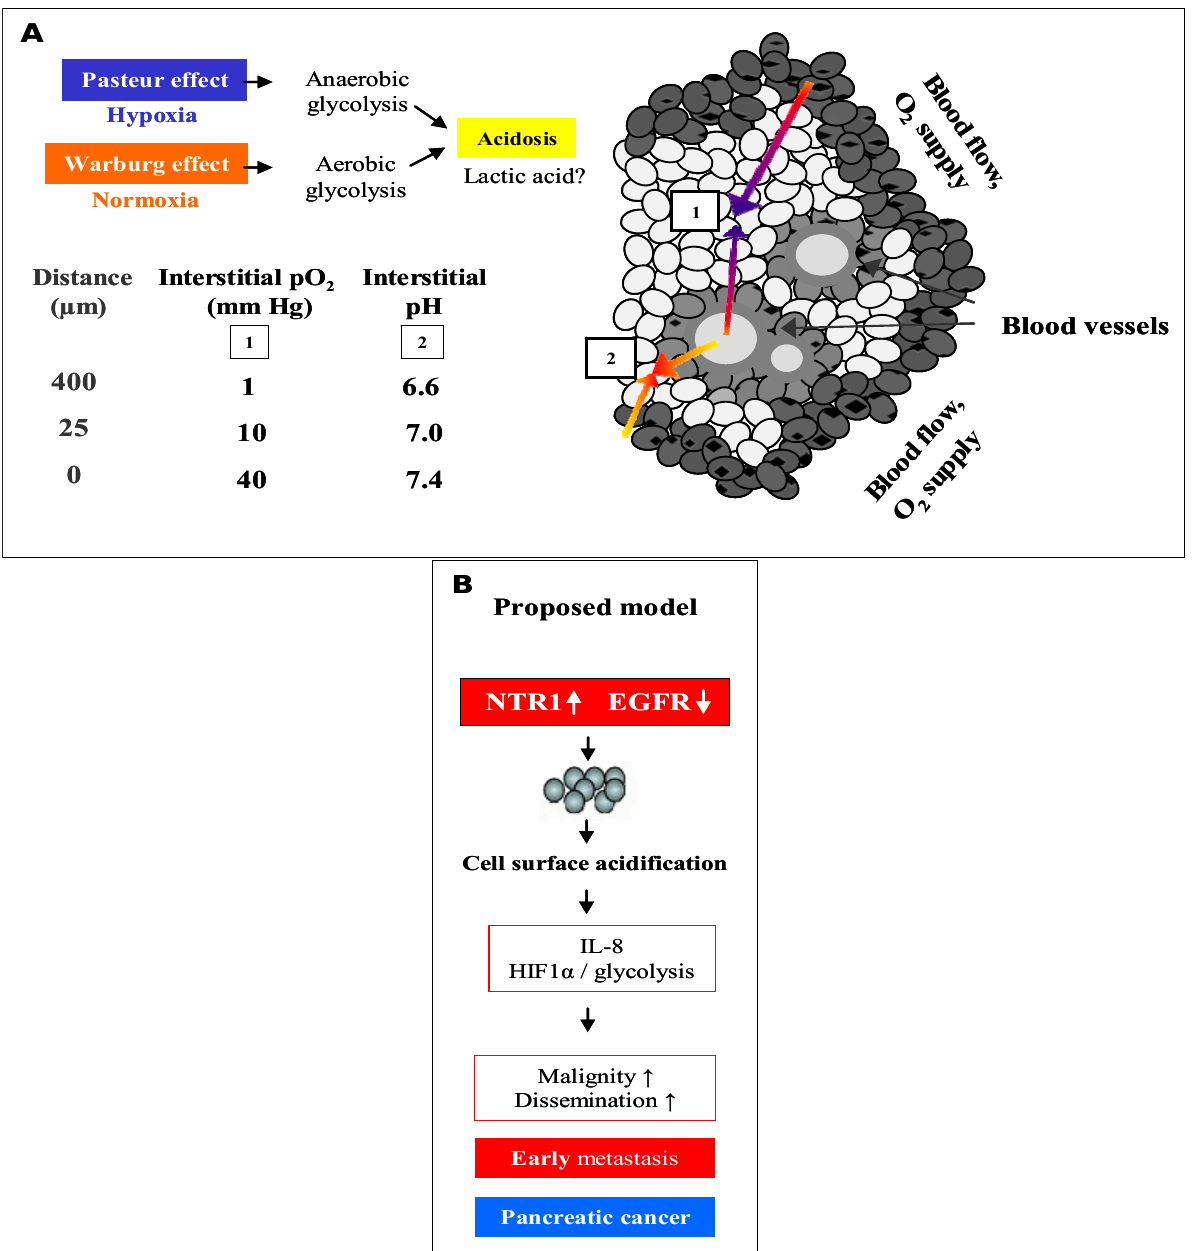
Figure 6. Proposed model of a mechanism that may be involved in metastasis and dissemination of pancreatic cancer already at an early stage of the disease. ( A ) Overview of the mechanisms leading to extracellular acidosis commonly found in solid tumors of larger size, and ( B ) proposed model for extracellular